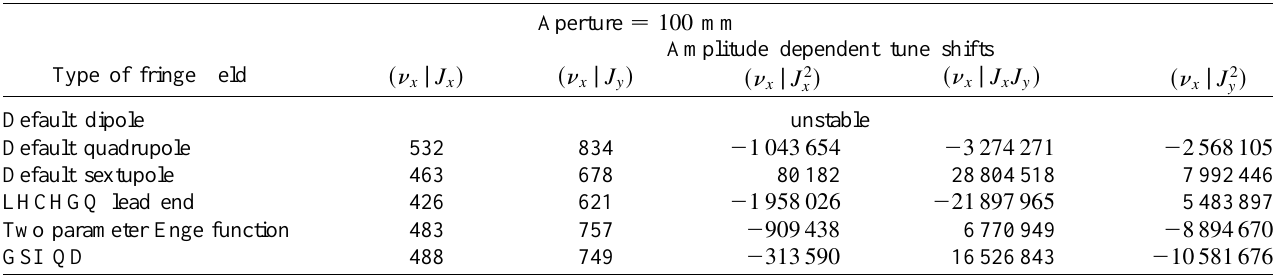
TABLE VII. A few amplitude dependent tune shifts for the 100 mm aperture case. All six of the studied fringe field fall-off shapes are